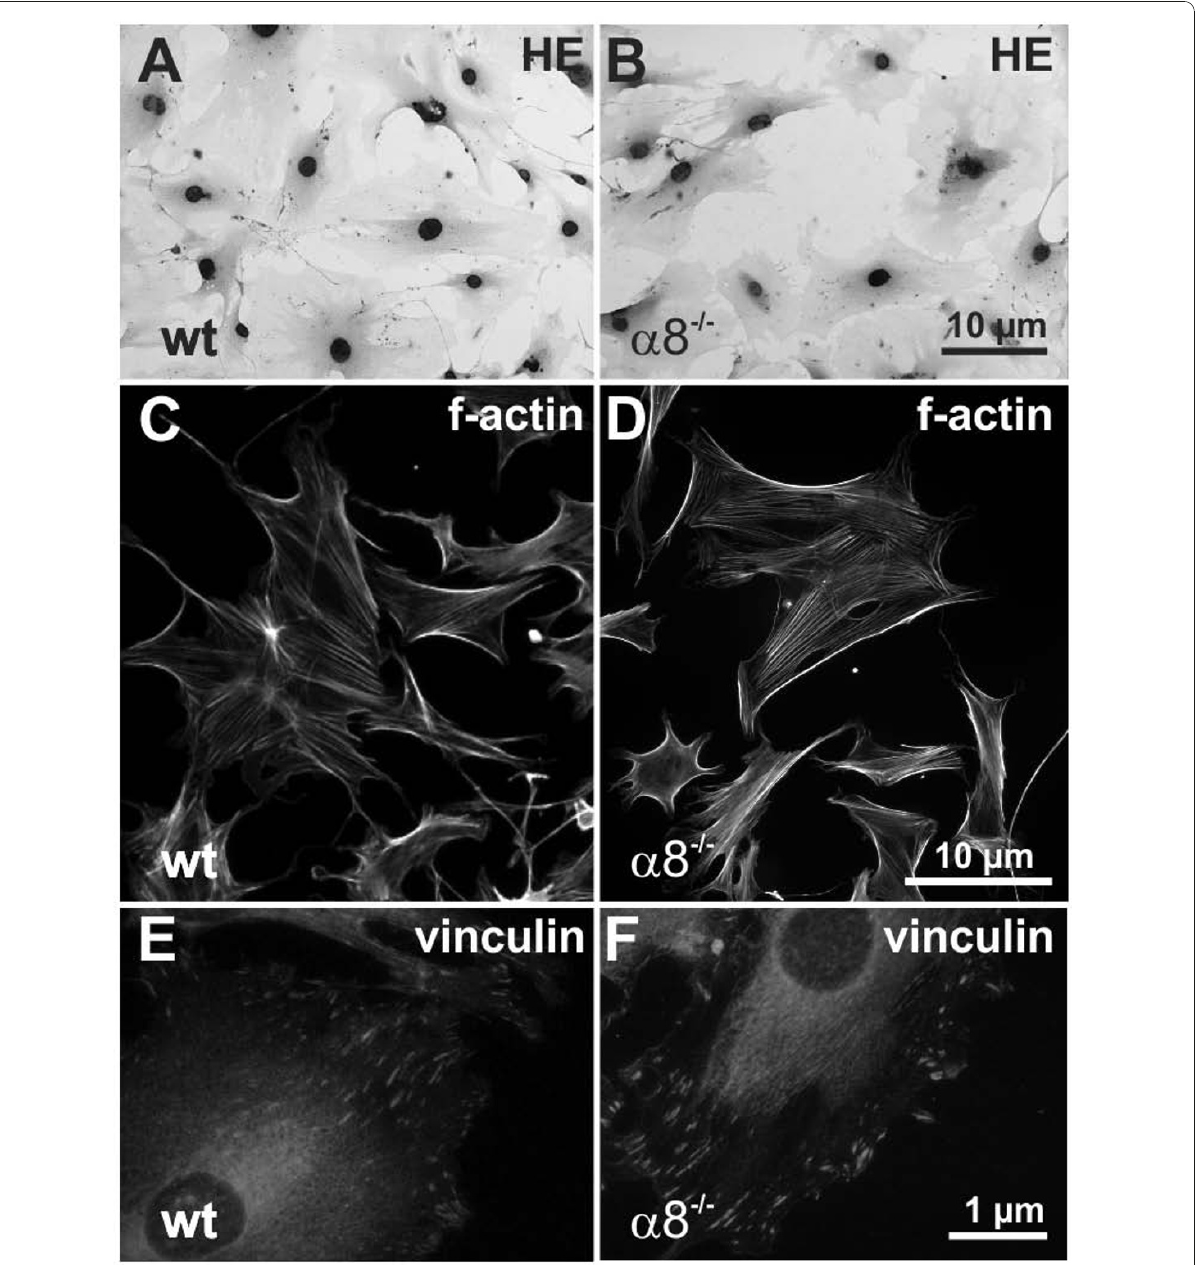
Figure 5 Comparison of wild type (wt) and a 8 integrin-deficient ( a 8-/-) vascular smooth muscle cell morphology after hematoxylin stain (A + B) or immunofluorescent staining for f-actin (C +D) or immunofluorescent staining for vinculin (E + F)